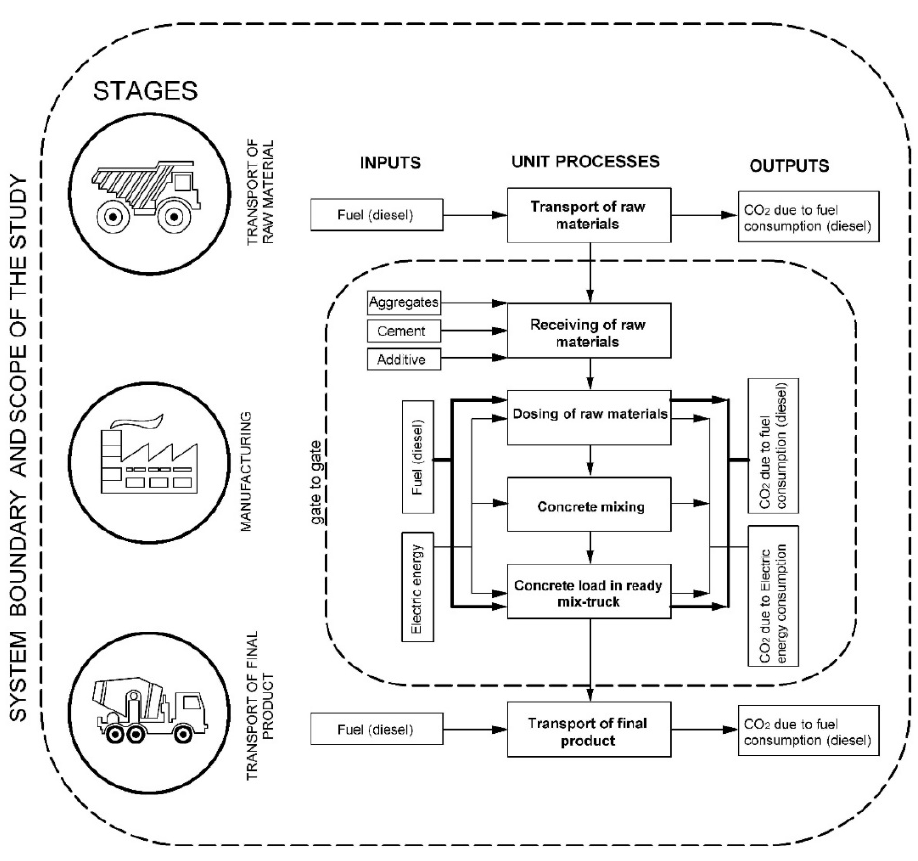
Figure 1. Flow chart of the ready-mixed concrete production.